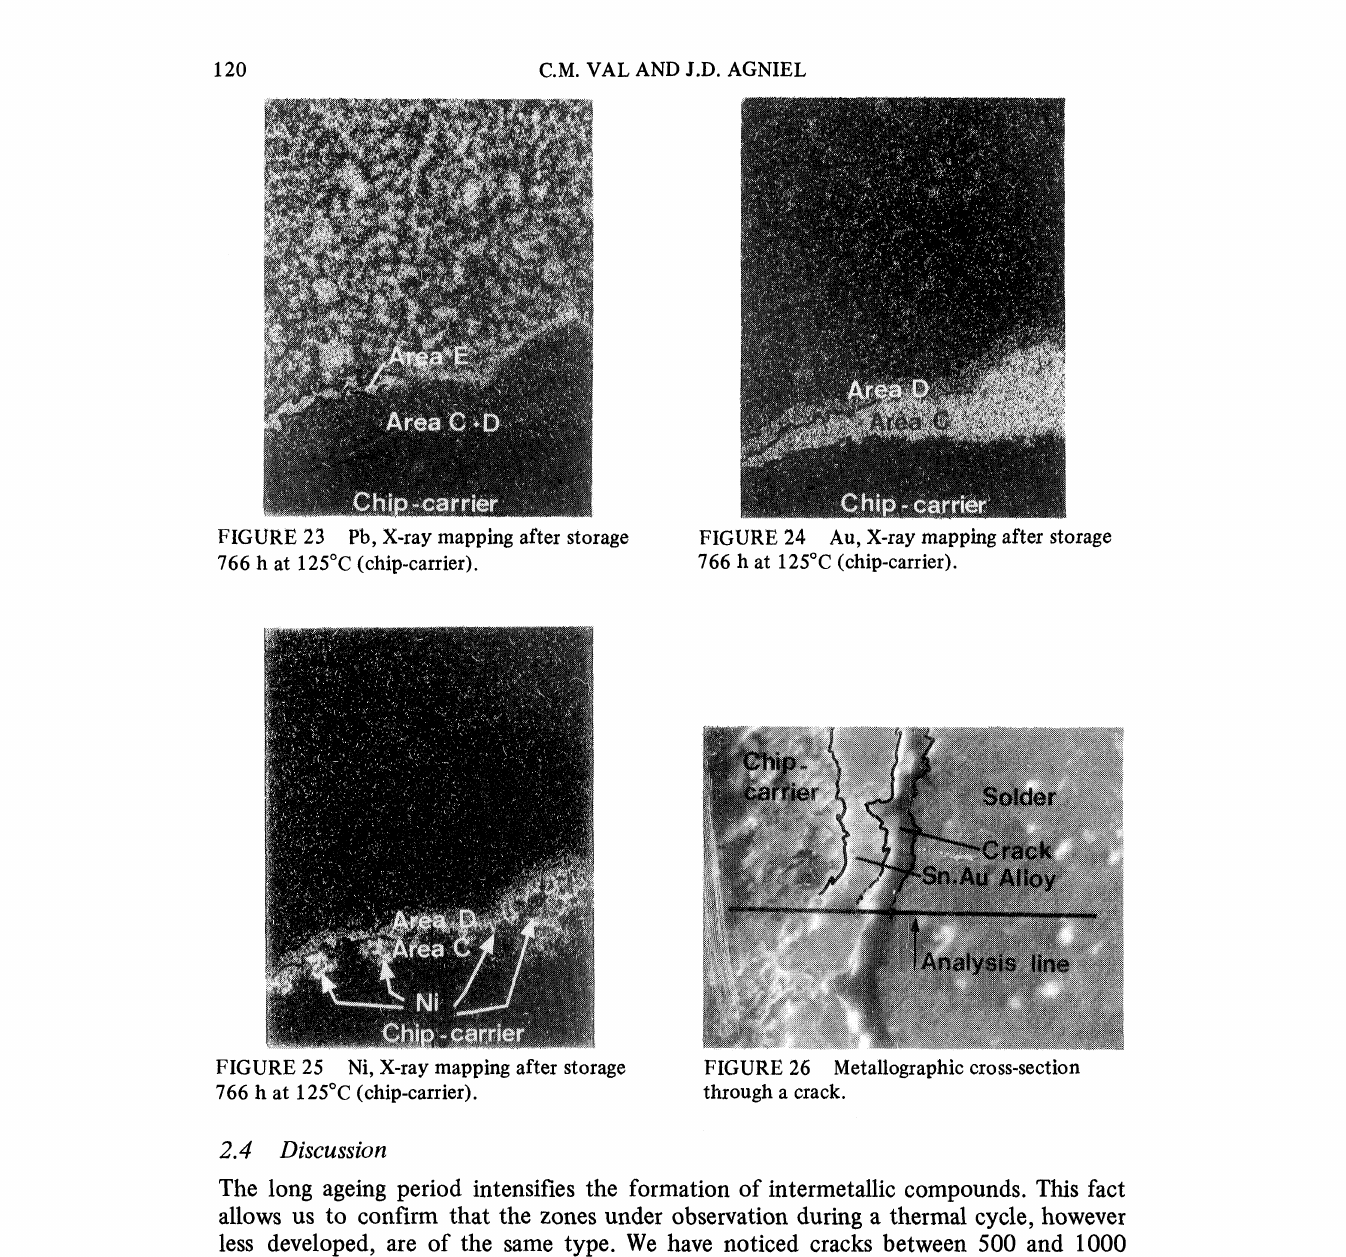
FIGURE 25 Ni, X-ray mapping after storage 766 h at 125C (chip-carrier).